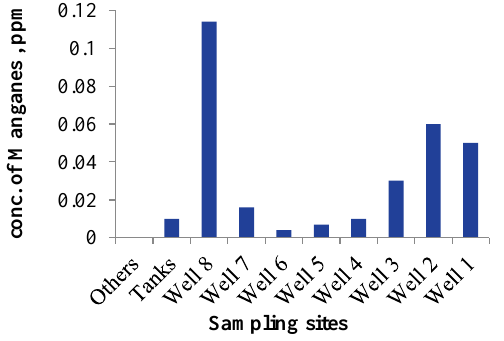
Figure 10. The average of Manganes (mg/l) in well, Tanks and others